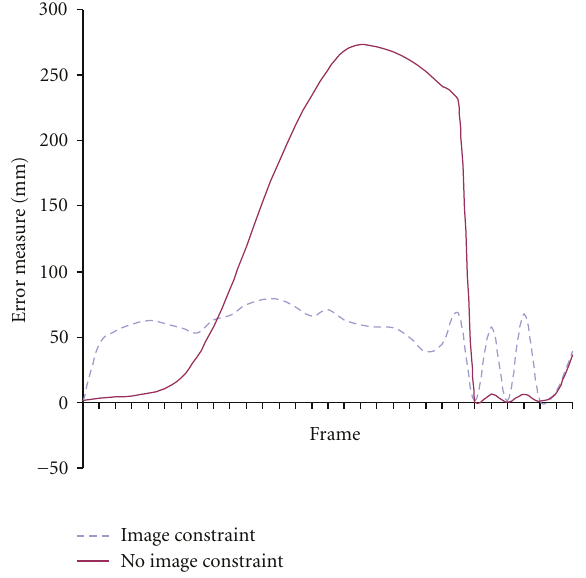
Figure 12: Elbow’s estimation error by frame of the box sequence.